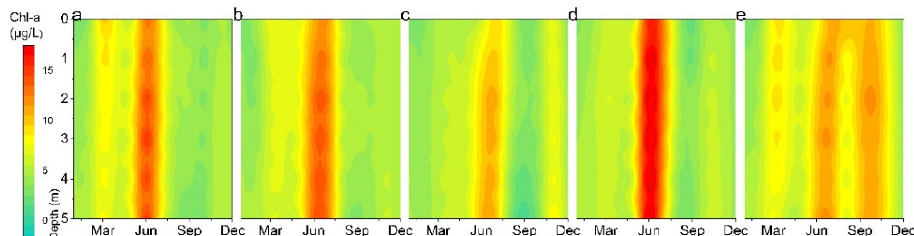
Figure 6. Spatiotemporal variation in chlorophyll in Lake Xingyun, measured during 2017. ( a ) XYH-1. ( b ) XYH-2. ( c ) XYH-3. ( d ) XYH-4. ( e ) XYH-5.